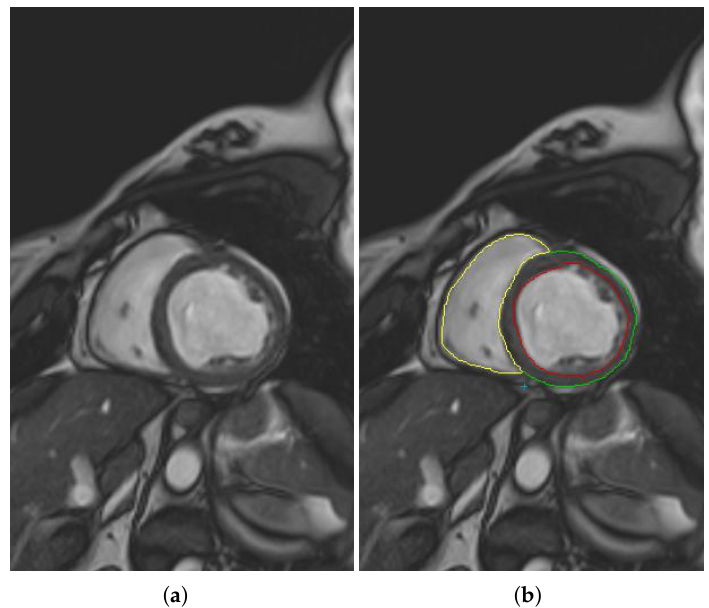
Figure 1. ( a ) Input cardiac magnetic resonance (CMR) slice. ( b ) Trabeculae included in the LV cavity (black delimited zone), RV cavity (yellow delimited zone), and external layer of the compact zone (yellow and green